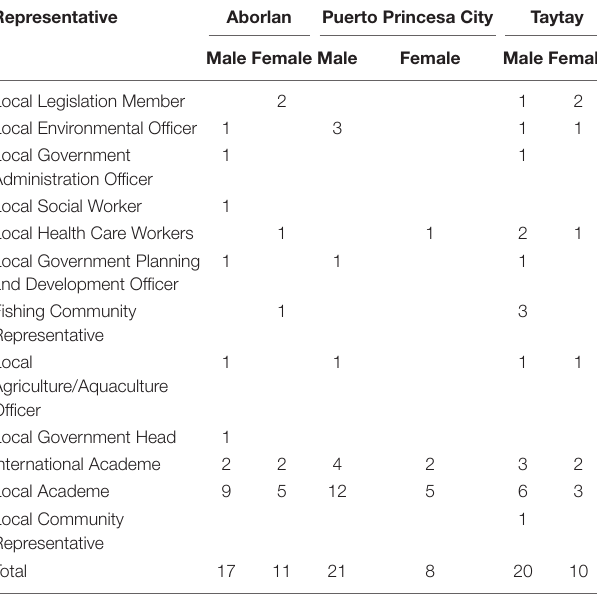
TABLE 1 | Demographic characteristics of the respondents ( N = 431). TABLE 2 | Representation of participants who attended the